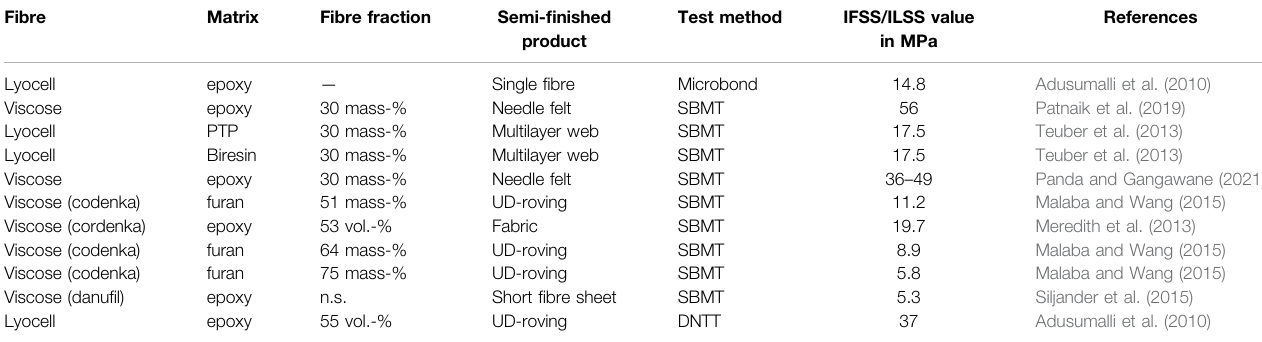
TABLE2| IFSSandILSSvaluesofregeneratedcellulose fi bre-reinforcedthermosettingmatricespresentedinliterature(IFSSmeasuredbymicrobond-tests,ILSSmeasured by short beam shear tests – SBMT or double-notched tensile tests – DNTT).